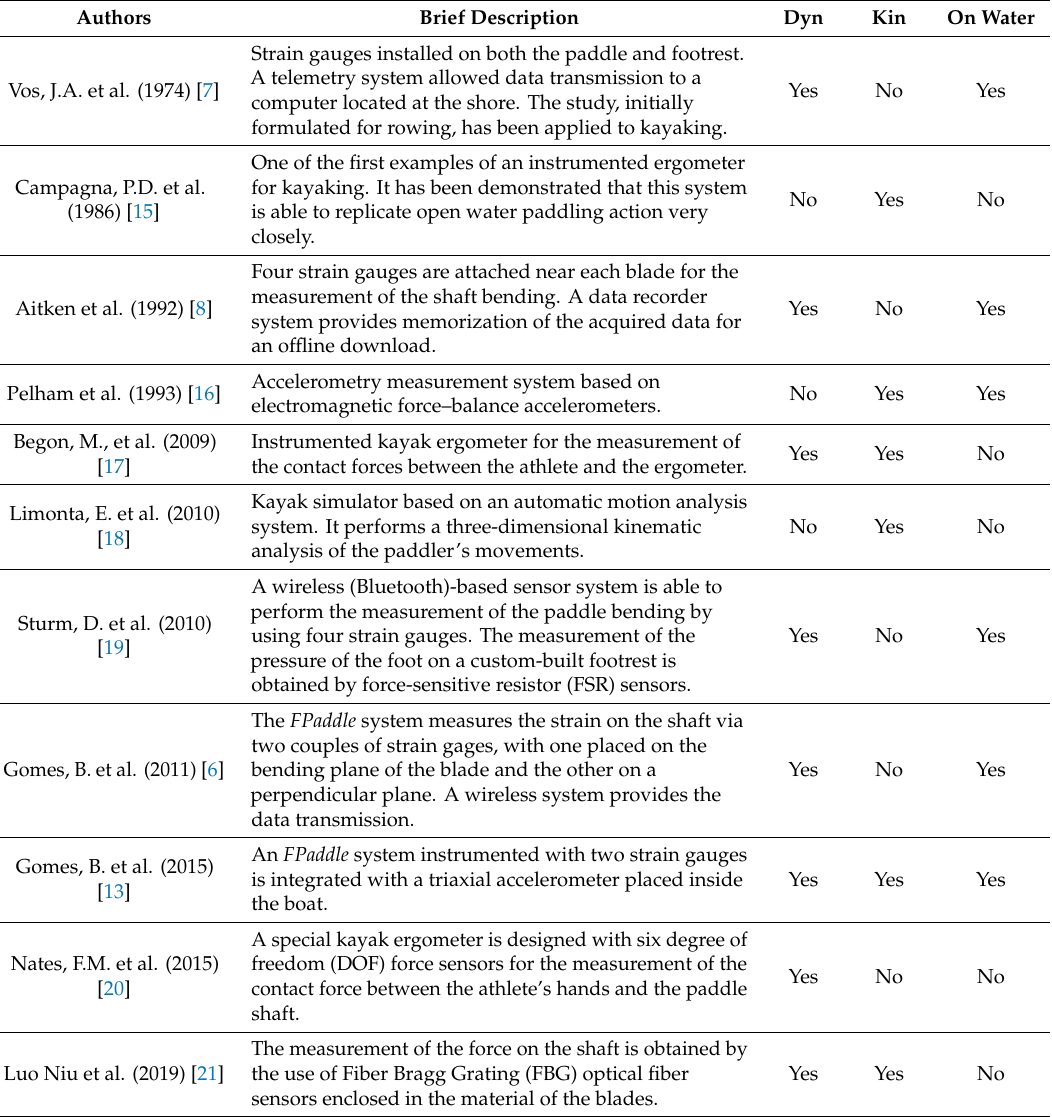
Table 1. State of the art on DAQ systems developed for kayaking Legend: Dyn, dynamic; Kin, kinematic. Authors Brief